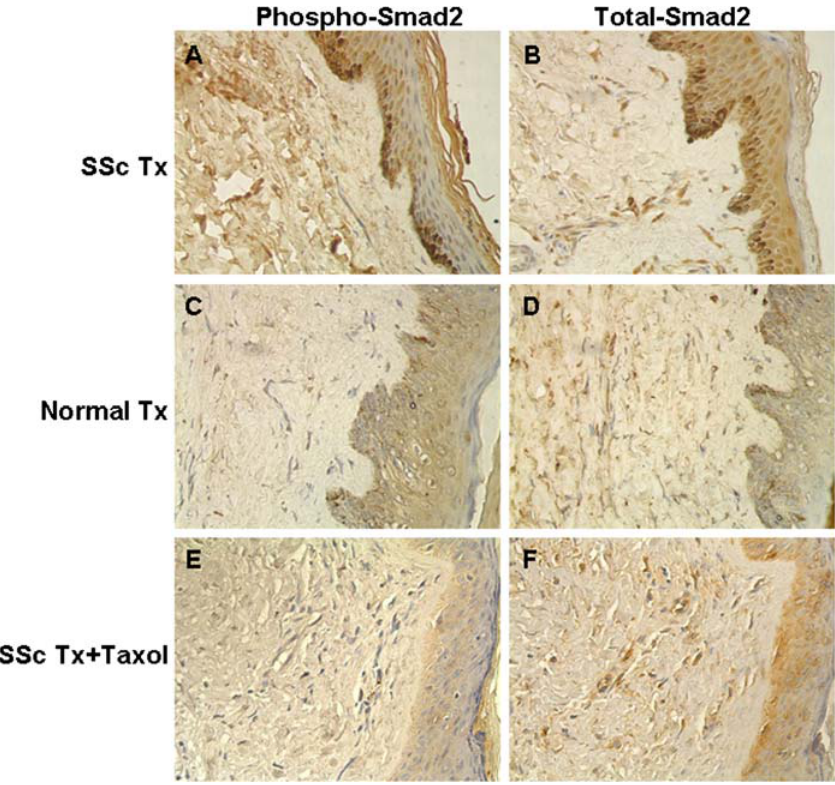
Figure 1. Paclitaxel Treatment Suppresses Smad2 Phosphorylation Strong nuclear staining for phospho-Smad2 (A) and total Smad2 (B) is observed in an SSc skin graft. Smad2 phosphorylation (C) is rare in normal graft, which expresses abundant Smad2 (D). Smad2 phosphorylation is suppressed with paclitaxel (Taxol) treatment (E), without affecting total Smad2 (F) in SSc skin graft. Tx, transplantation. DOI: 10.1371/journal.pmed.0020354.g001